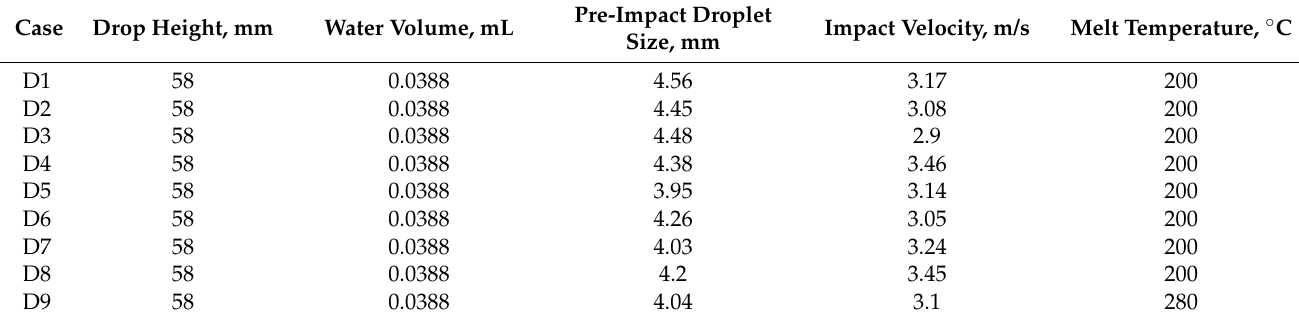
Table 2. Parameters of free-falling droplet impact